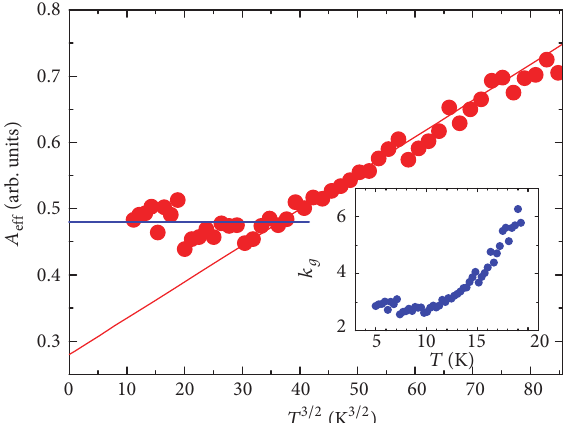
Figure7:Evaluatedtemperaturedependence 𝐴 eff (𝑇) at 𝐻 = 80 kOe (symbols). Lines are plotted according to (5). Inset: the temperature dependence of the calculated coefficient 𝑘 𝑔